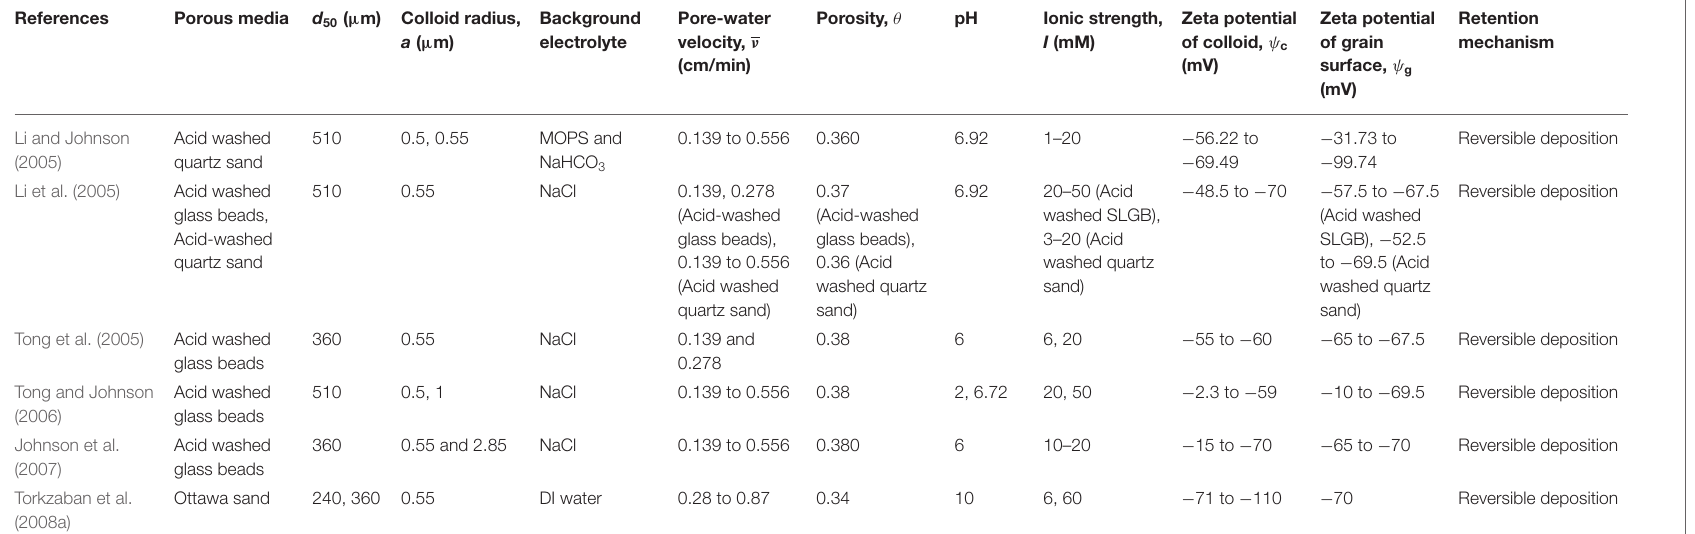
TABLE 6 | Experimental conditions in papers selected to analyse deposition of CML